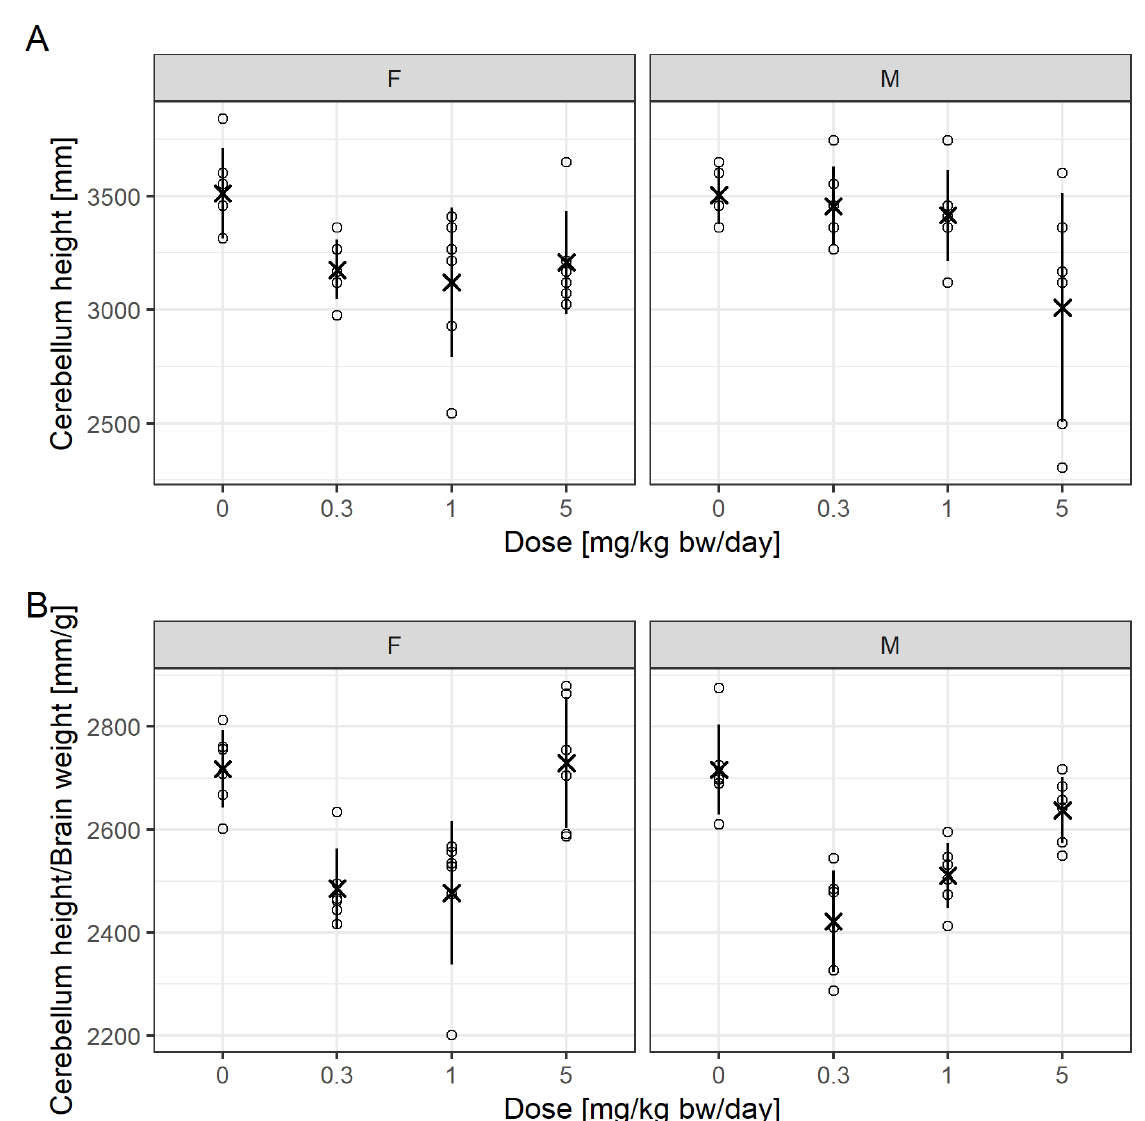
Figure 6: Data from Mie et al. (2018), showing cerebellum height and cerebellum height to brain weight over dose of Chlorpyrifos, with individual values (open circles) added along with mean values (multipli- cation sign) and standard deviation (line range), which can be added by applying a custom